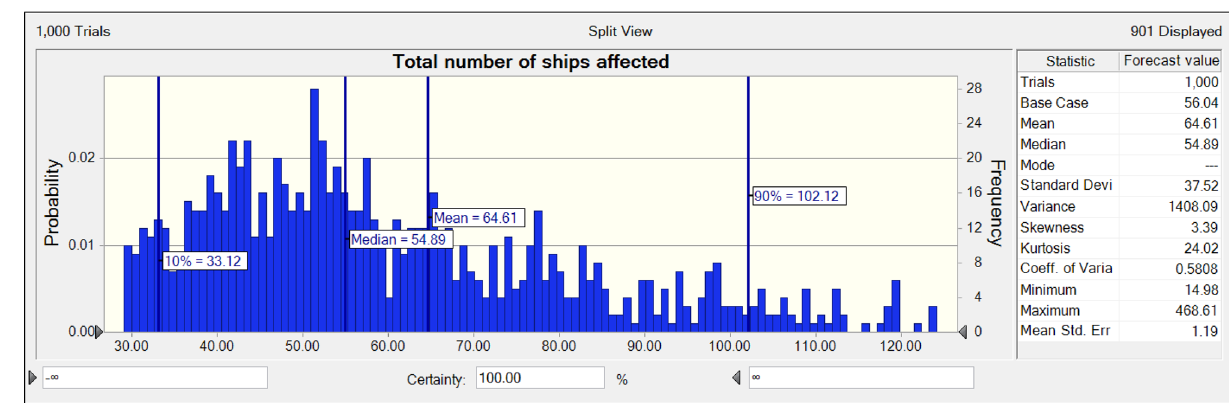
Fig. 11 Simulation result of the number of ships affected ( T